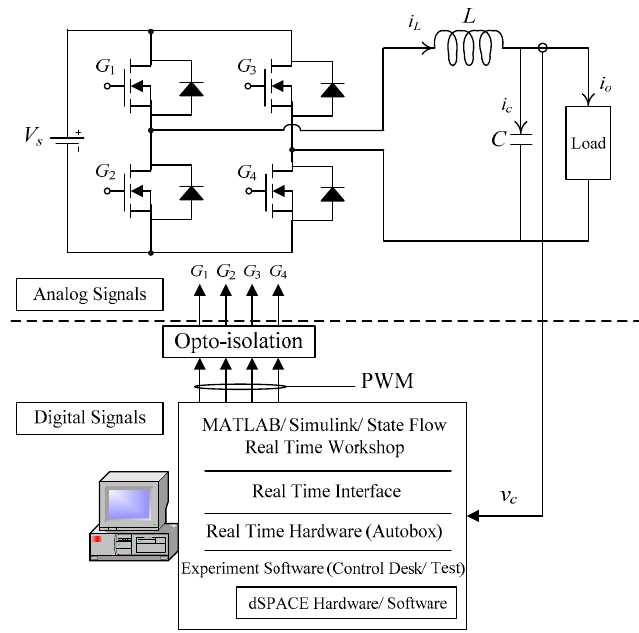
Figure 6. Improved algorithm for DSP (digital signal processing)-based implementation.